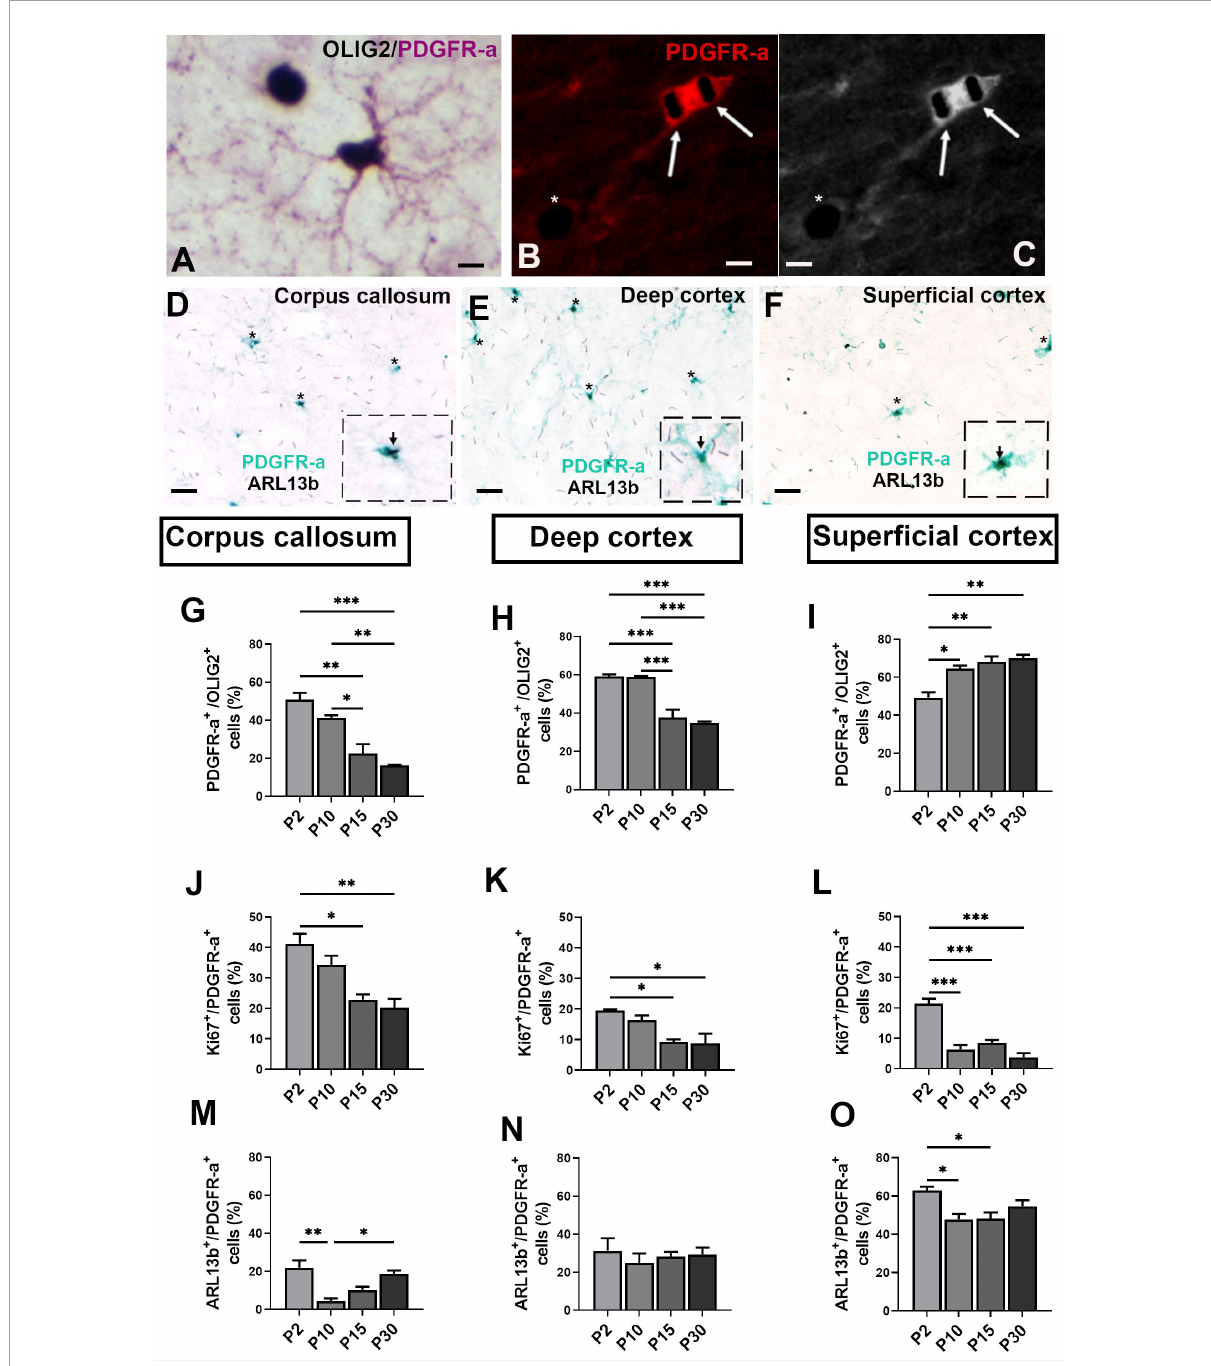
FIGURE3 Ciliated oligodendroglial cells distribution in corpus callosum and cortex during mouse post-natal development. (A,B) Representative images of double staining PDGFR-a/OLIG2 (A) and Ki67/PDGFR-a (B,C) , respectively. Arrows in (B) indicate Ki67 + nuclei staining in black (SG HRP Substrate) in a PDGFR-a + cell (red fluorochrome) and asterisk shown a Ki67 + nucleus in a PDGFR-a − cell. (C) Black and white image of (B) . (D–F) Representative image of ciliated PDGFR-a + cells in mouse corpus callosum, deep and superficial cortex at post-natal day 15. Asterisks indicate primary cilia stained with ARL13b in black (SG HRP Substrate) in PDGFR-a + cells stained by a green HRP Substrate (HistoGreen). In the dotted squares, high magnification of a PDGFR + /ARL13b + cells. (G–O) Quantification of PDGFR-a + (G–I) , Ki67 + (J–L) and ARL13b + cells (M–O) in corpus callosum, deep and superficial cortex. Groups were compared using one-way ANOVA followed by Bonferroni post-hoc test. Data are presented as mean ± error of the mean (SEM) and asterisks indicate: * p < 0.05, ** p < 0.01, *** p < 0.001; the values for n are available in Supplementary Table 4 . Scale bar is 10 µ m in (A–C) and 20 µ m in (D–F) . The inspected cells for the evaluation of ciliated PDGFR-a + percentage was 40–50 cells repeated in three different slices for each animal and each anatomical region studied at the different